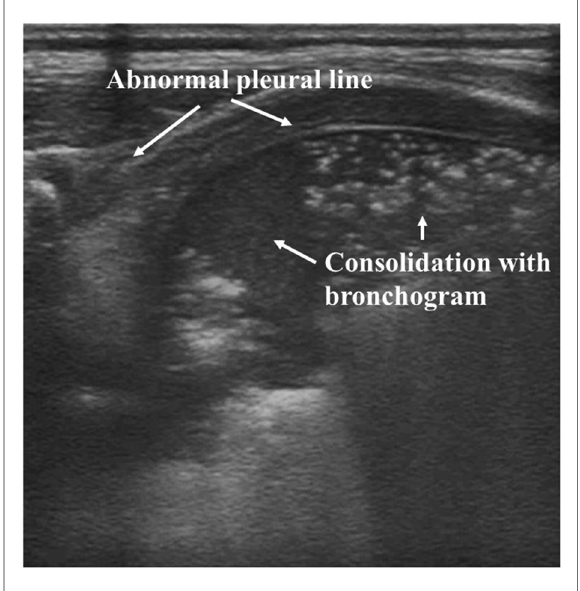
FIGURE 8 Atelectasis on lung ultrasonography. Ultrasound shows abnormal pleural lines, absent A-lines, and large areas of